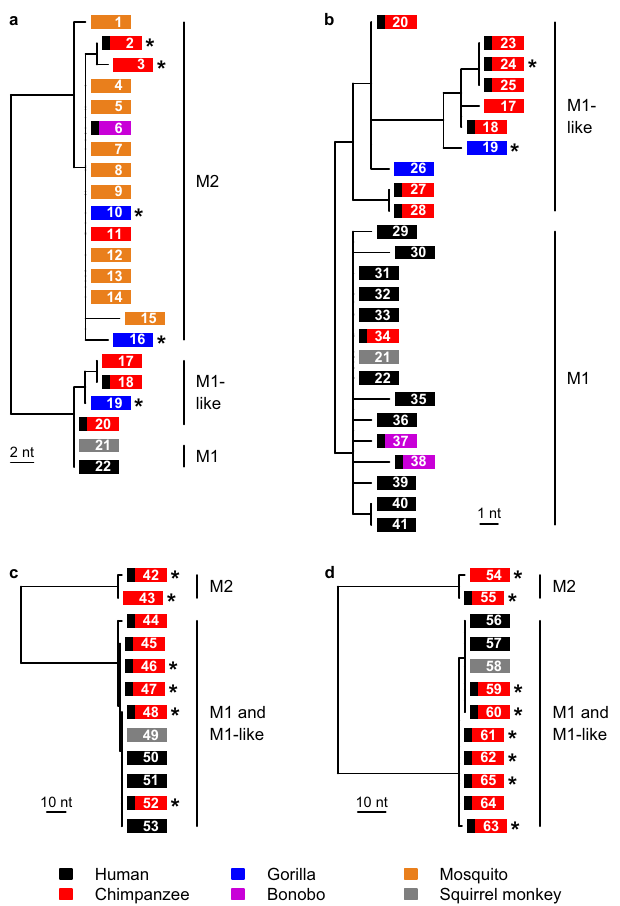
Fig. 1 Phylogenetic relationships among M1 strains (including P. malariae ) and the two ape-infective lineages M1-like and M2. a Maximum likelihood tree derived from a 641 bp mitochondrial DNA cytB fragment; this tree includes all available M2 cytB sequences, but for clarity includes only a few, representative M1 and M1-like sequences. b Maximum likelihood tree derived from a 2,038 bp mitochondrial cytB / cox1 fragment; this tree includes all available sequences of suf fi cient length from these lineages, and was generated from a longer alignment that encompasses the region in part a (see Supplementary Fig. 1). c Maximum likelihood tree derived from a 682 bp asl fragment. d Maximum likelihood tree derived from a 724 bp ldh fragment. Boxes represent sequences and are coloured according to the host from which the sample was derived, as indicated in the key. A black bar at the left of a box indicates a sample from a captive or sanctuary ape; asterisks denote newly derived sequences; numbers in the boxes give the sequence code (Supplementary Table 2). Bootstrap support from 1,000 replicates was 100% for the nodes separating M2 from M1 and M1-like, and for the node separating M1 from M1-like in part b . Scale bars indicate the number of nucleotide